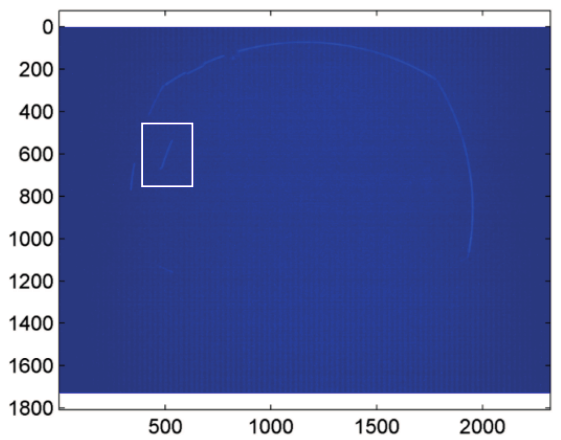
Figure 10. Example of frame acquired by the camera for testing the sensor